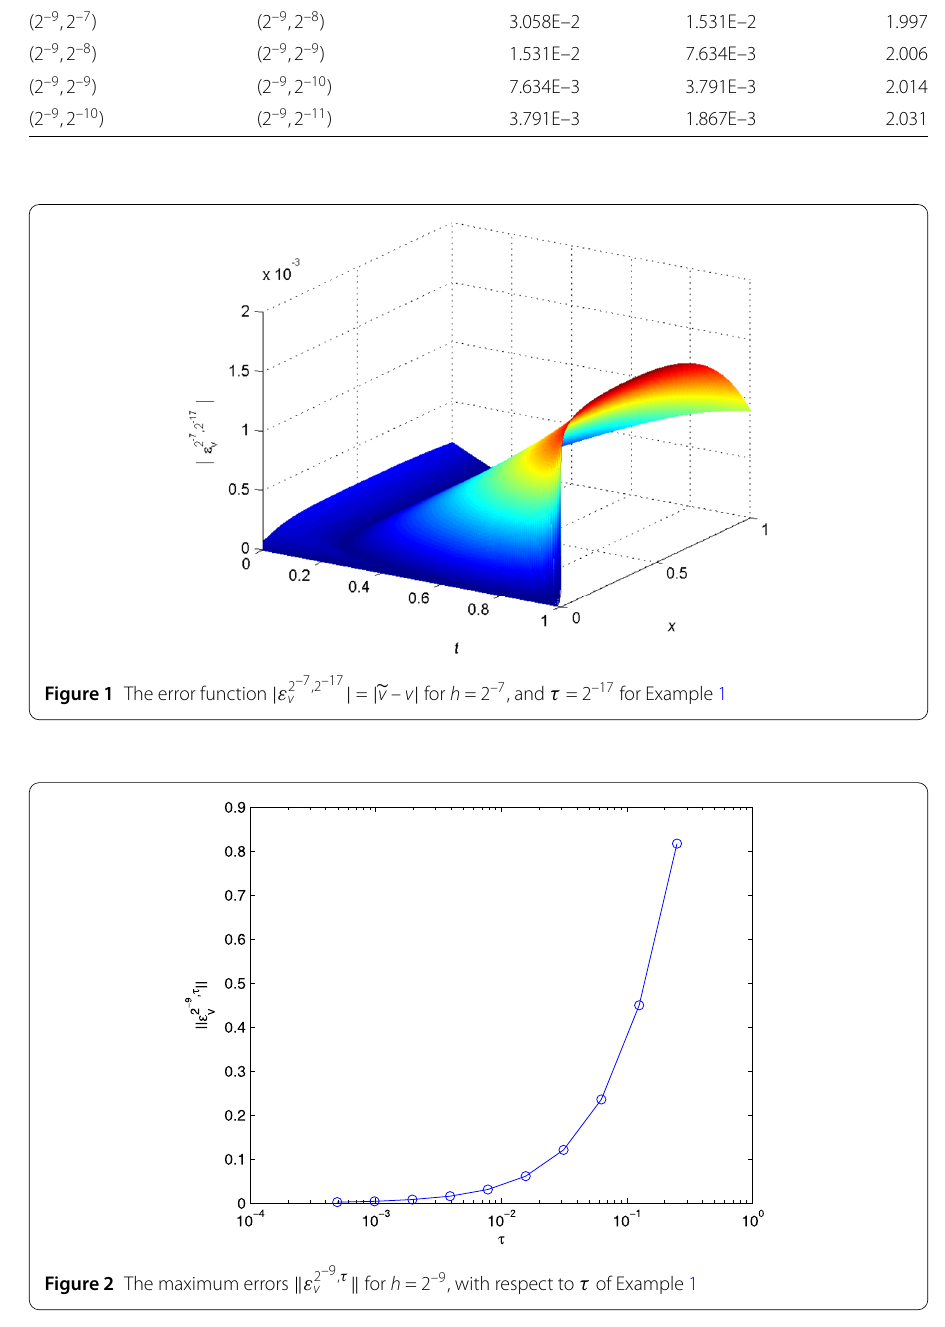
Figure 2 The maximum errors (cid:7) ε